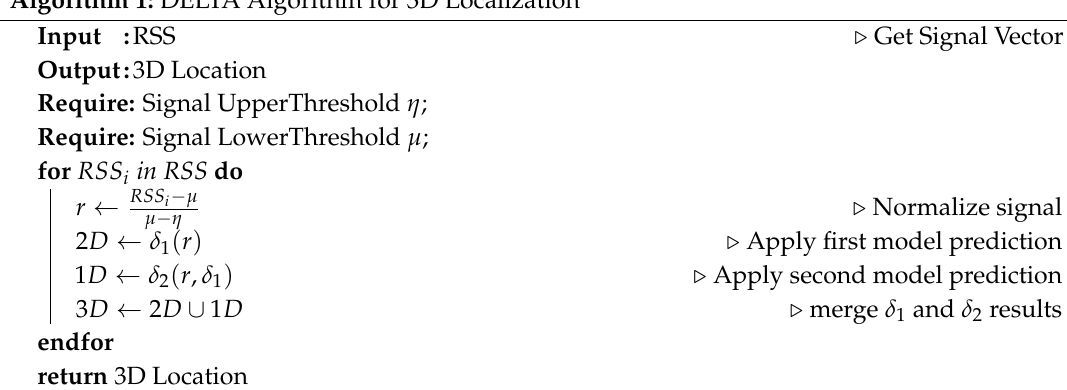
Algorithm 1: DELTA Algorithm for 3D